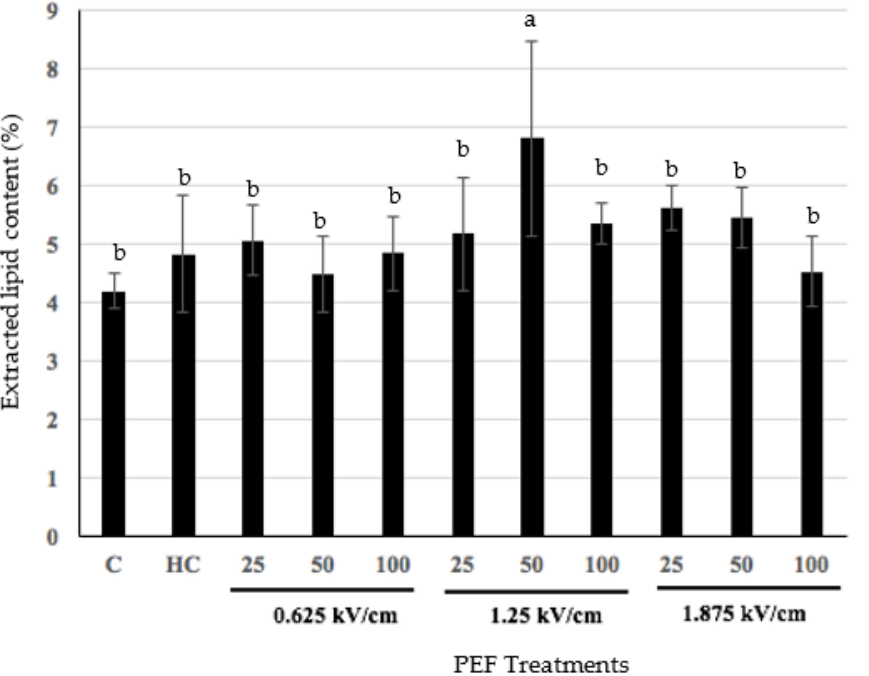
Figure 1. Effect of frequency and pulsed electric field strength on extracted lipid yield (%) from HMG samples. C represents un-heated control, and HC represents heat-treated control. Different letters (a,b) for PEF parameters (frequency and PEF field strength) indicate a significant difference ( p < 0.05) in lipid yield.